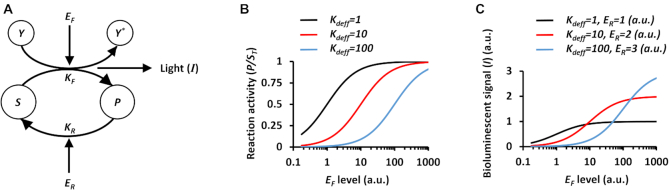
Bacterial bioluminescence model. (A) Scheme of light generation by luxCDABE cassette, where \documentclass[12pt]{minimal}
\usepackage{amsmath}
\usepackage{wasysym}
\usepackage{amsfonts}
\usepackage{amssymb}
\usepackage{amsbsy}
\usepackage{upgreek}
\usepackage{mathrsfs}
\setlength{\oddsidemargin}{-69pt}
\begin{document}
}{}$S$\end{document} represents the concentration of \documentclass[12pt]{minimal}
\usepackage{amsmath}
\usepackage{wasysym}
\usepackage{amsfonts}
\usepackage{amssymb}
\usepackage{amsbsy}
\usepackage{upgreek}
\usepackage{mathrsfs}
\setlength{\oddsidemargin}{-69pt}
\begin{document}
}{}$R - CHO$\end{document}, \documentclass[12pt]{minimal}
\usepackage{amsmath}
\usepackage{wasysym}
\usepackage{amsfonts}
\usepackage{amssymb}
\usepackage{amsbsy}
\usepackage{upgreek}
\usepackage{mathrsfs}
\setlength{\oddsidemargin}{-69pt}
\begin{document}
}{}$P$\end{document} represents the concentration of \documentclass[12pt]{minimal}
\usepackage{amsmath}
\usepackage{wasysym}
\usepackage{amsfonts}
\usepackage{amssymb}
\usepackage{amsbsy}
\usepackage{upgreek}
\usepackage{mathrsfs}
\setlength{\oddsidemargin}{-69pt}
\begin{document}
}{}$R - COOH$\end{document}, \documentclass[12pt]{minimal}
\usepackage{amsmath}
\usepackage{wasysym}
\usepackage{amsfonts}
\usepackage{amssymb}
\usepackage{amsbsy}
\usepackage{upgreek}
\usepackage{mathrsfs}
\setlength{\oddsidemargin}{-69pt}
\begin{document}
}{}$Y$\end{document} represents the concentration of \documentclass[12pt]{minimal}
\usepackage{amsmath}
\usepackage{wasysym}
\usepackage{amsfonts}
\usepackage{amssymb}
\usepackage{amsbsy}
\usepackage{upgreek}
\usepackage{mathrsfs}
\setlength{\oddsidemargin}{-69pt}
\begin{document}
}{}$FMN{H_2}$\end{document} and \documentclass[12pt]{minimal}
\usepackage{amsmath}
\usepackage{wasysym}
\usepackage{amsfonts}
\usepackage{amssymb}
\usepackage{amsbsy}
\usepackage{upgreek}
\usepackage{mathrsfs}
\setlength{\oddsidemargin}{-69pt}
\begin{document}
}{}${Y^*}$\end{document} represents the concentration of \documentclass[12pt]{minimal}
\usepackage{amsmath}
\usepackage{wasysym}
\usepackage{amsfonts}
\usepackage{amssymb}
\usepackage{amsbsy}
\usepackage{upgreek}
\usepackage{mathrsfs}
\setlength{\oddsidemargin}{-69pt}
\begin{document}
}{}$FMN$\end{document}. \documentclass[12pt]{minimal}
\usepackage{amsmath}
\usepackage{wasysym}
\usepackage{amsfonts}
\usepackage{amssymb}
\usepackage{amsbsy}
\usepackage{upgreek}
\usepackage{mathrsfs}
\setlength{\oddsidemargin}{-69pt}
\begin{document}
}{}${E_{F\ }}$\end{document} represents the expression level of the enzyme involved in the forward reaction (luciferase) and \documentclass[12pt]{minimal}
\usepackage{amsmath}
\usepackage{wasysym}
\usepackage{amsfonts}
\usepackage{amssymb}
\usepackage{amsbsy}
\usepackage{upgreek}
\usepackage{mathrsfs}
\setlength{\oddsidemargin}{-69pt}
\begin{document}
}{}${E_{R\ }}$\end{document} represents the expression level of enzymes involved in the reverse reaction (transferase, synthetase, and reductase). \documentclass[12pt]{minimal}
\usepackage{amsmath}
\usepackage{wasysym}
\usepackage{amsfonts}
\usepackage{amssymb}
\usepackage{amsbsy}
\usepackage{upgreek}
\usepackage{mathrsfs}
\setlength{\oddsidemargin}{-69pt}
\begin{document}
}{}${K_F}$\end{document} represents the rate of the forward reaction and \documentclass[12pt]{minimal}
\usepackage{amsmath}
\usepackage{wasysym}
\usepackage{amsfonts}
\usepackage{amssymb}
\usepackage{amsbsy}
\usepackage{upgreek}
\usepackage{mathrsfs}
\setlength{\oddsidemargin}{-69pt}
\begin{document}
}{}${K_R}$\end{document} represents the rate of the reverse reaction. (B) Simulation results demonstrating the relationship between the \documentclass[12pt]{minimal}
\usepackage{amsmath}
\usepackage{wasysym}
\usepackage{amsfonts}
\usepackage{amssymb}
\usepackage{amsbsy}
\usepackage{upgreek}
\usepackage{mathrsfs}
\setlength{\oddsidemargin}{-69pt}
\begin{document}
}{}${E_{F\ }}$\end{document} level and the reaction activity at varying \documentclass[12pt]{minimal}
\usepackage{amsmath}
\usepackage{wasysym}
\usepackage{amsfonts}
\usepackage{amssymb}
\usepackage{amsbsy}
\usepackage{upgreek}
\usepackage{mathrsfs}
\setlength{\oddsidemargin}{-69pt}
\begin{document}
}{}${E_{R\ }}$\end{document} levels, where \documentclass[12pt]{minimal}
\usepackage{amsmath}
\usepackage{wasysym}
\usepackage{amsfonts}
\usepackage{amssymb}
\usepackage{amsbsy}
\usepackage{upgreek}
\usepackage{mathrsfs}
\setlength{\oddsidemargin}{-69pt}
\begin{document}
}{}$P$\end{document} is normalized by \documentclass[12pt]{minimal}
\usepackage{amsmath}
\usepackage{wasysym}
\usepackage{amsfonts}
\usepackage{amssymb}
\usepackage{amsbsy}
\usepackage{upgreek}
\usepackage{mathrsfs}
\setlength{\oddsidemargin}{-69pt}
\begin{document}
}{}${S_T}$\end{document}, the total concentration of the \documentclass[12pt]{minimal}
\usepackage{amsmath}
\usepackage{wasysym}
\usepackage{amsfonts}
\usepackage{amssymb}
\usepackage{amsbsy}
\usepackage{upgreek}
\usepackage{mathrsfs}
\setlength{\oddsidemargin}{-69pt}
\begin{document}
}{}$S$\end{document} molecule. \documentclass[12pt]{minimal}
\usepackage{amsmath}
\usepackage{wasysym}
\usepackage{amsfonts}
\usepackage{amssymb}
\usepackage{amsbsy}
\usepackage{upgreek}
\usepackage{mathrsfs}
\setlength{\oddsidemargin}{-69pt}
\begin{document}
}{}${K_{deff}}$\end{document} can be viewed as a detection threshold that depends on the level of \documentclass[12pt]{minimal}
\usepackage{amsmath}
\usepackage{wasysym}
\usepackage{amsfonts}
\usepackage{amssymb}
\usepackage{amsbsy}
\usepackage{upgreek}
\usepackage{mathrsfs}
\setlength{\oddsidemargin}{-69pt}
\begin{document}
}{}${E_{R\ }}$\end{document} according to \documentclass[12pt]{minimal}
\usepackage{amsmath}
\usepackage{wasysym}
\usepackage{amsfonts}
\usepackage{amssymb}
\usepackage{amsbsy}
\usepackage{upgreek}
\usepackage{mathrsfs}
\setlength{\oddsidemargin}{-69pt}
\begin{document}
}{}$\ {K_{deff}} \equiv \frac{{{K_R} \cdot {E_R}}}{{{K_F}}}$\end{document}. (C) Simulation results demonstrating the relationship between the \documentclass[12pt]{minimal}
\usepackage{amsmath}
\usepackage{wasysym}
\usepackage{amsfonts}
\usepackage{amssymb}
\usepackage{amsbsy}
\usepackage{upgreek}
\usepackage{mathrsfs}
\setlength{\oddsidemargin}{-69pt}
\begin{document}
}{}${E_{F\ }}$\end{document}level and bioluminescent signal (I), at varying \documentclass[12pt]{minimal}
\usepackage{amsmath}
\usepackage{wasysym}
\usepackage{amsfonts}
\usepackage{amssymb}
\usepackage{amsbsy}
\usepackage{upgreek}
\usepackage{mathrsfs}
\setlength{\oddsidemargin}{-69pt}
\begin{document}
}{}${E_{R\ }}$\end{document} levels.